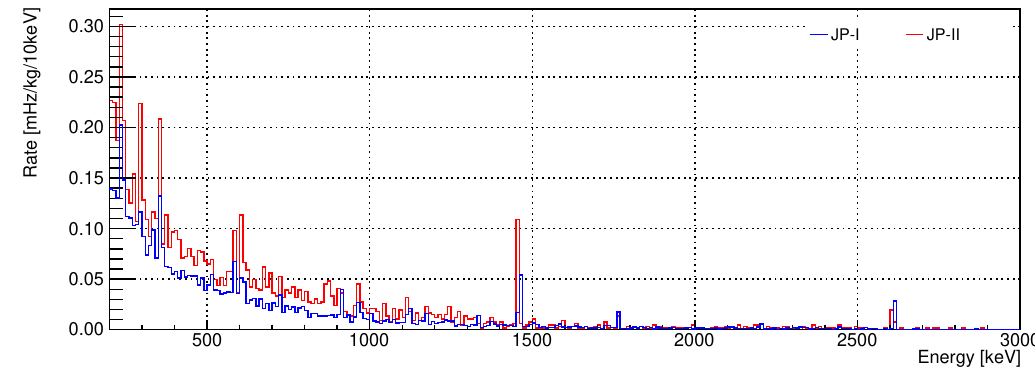
Figure 2. Background spectra of JP-I (blue line) and JP-II (red line) HPGe detectors. The counting rate is normalized by the mass of germanium